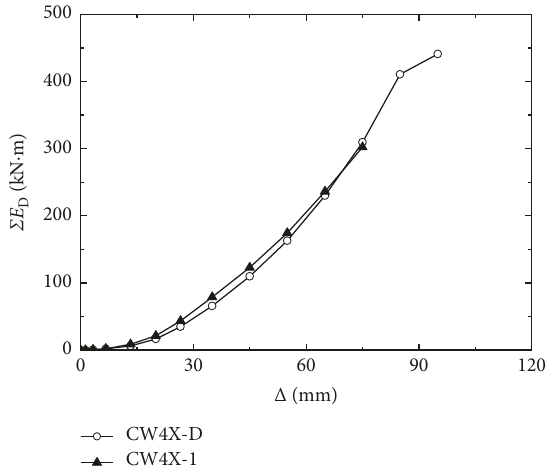
Figure 10: Cumulative energy